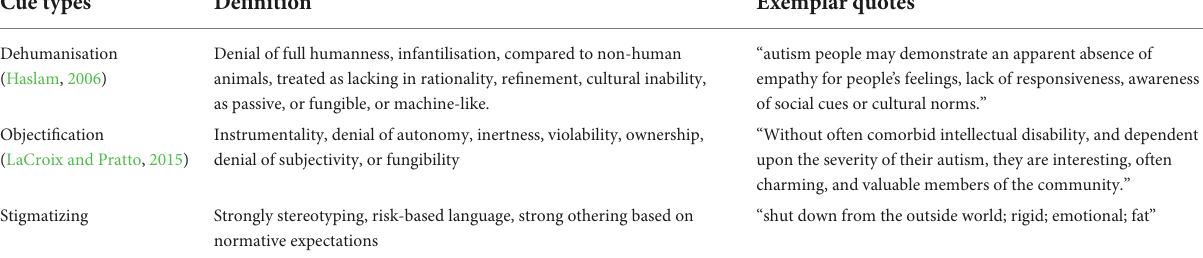
TABLE 4 Ableism cues, their definition and example